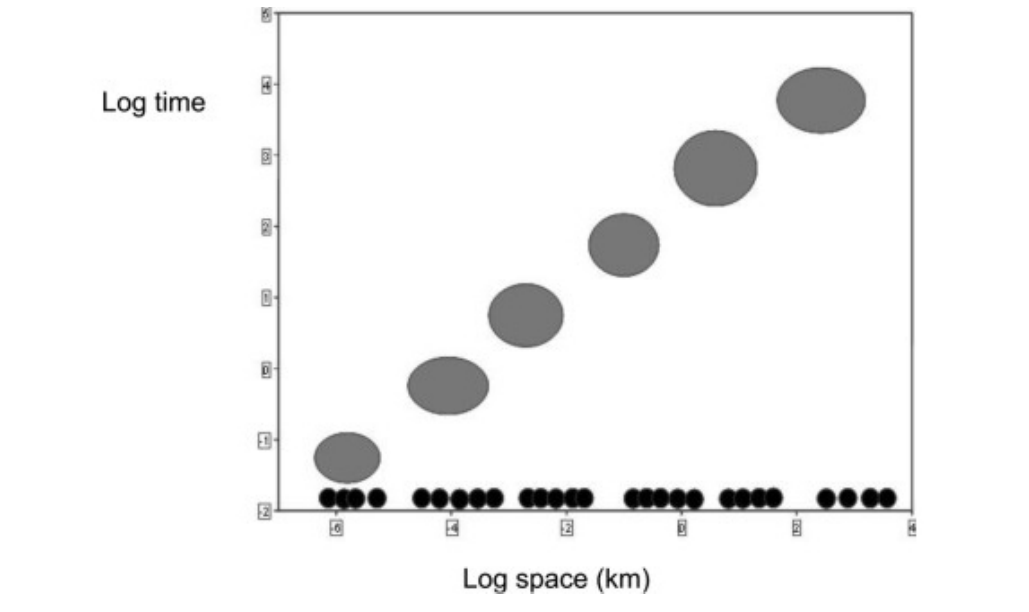
Fig. 3 . Discontinuous body mass distributions (black circles on x-axis representing animal body masses along a body mass axis) reflect the levels of scale (grey circlular regions, representing space-time domains of structures) available in a given system, which in turn reflect the underlying panarchy. The x axis represents both spatial scale of processes and a body mass axis for species inhabiting the